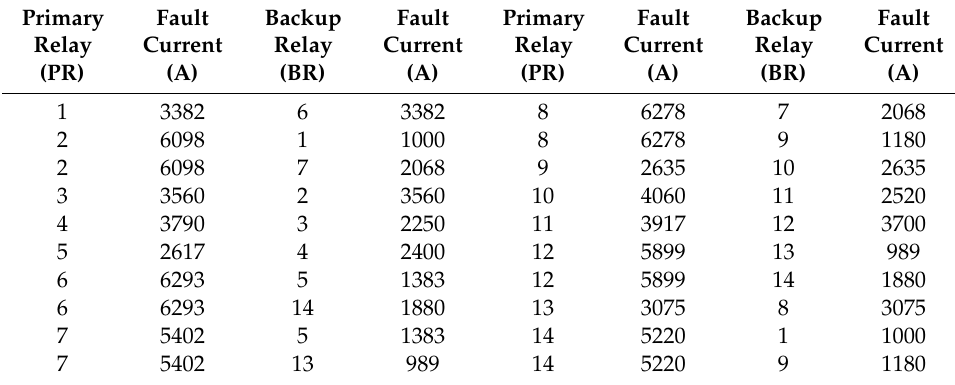
Table 2. Fault current for primary and backup (P / B) directional overcurrent relays (DOCRs) pairs of 8-bus network.